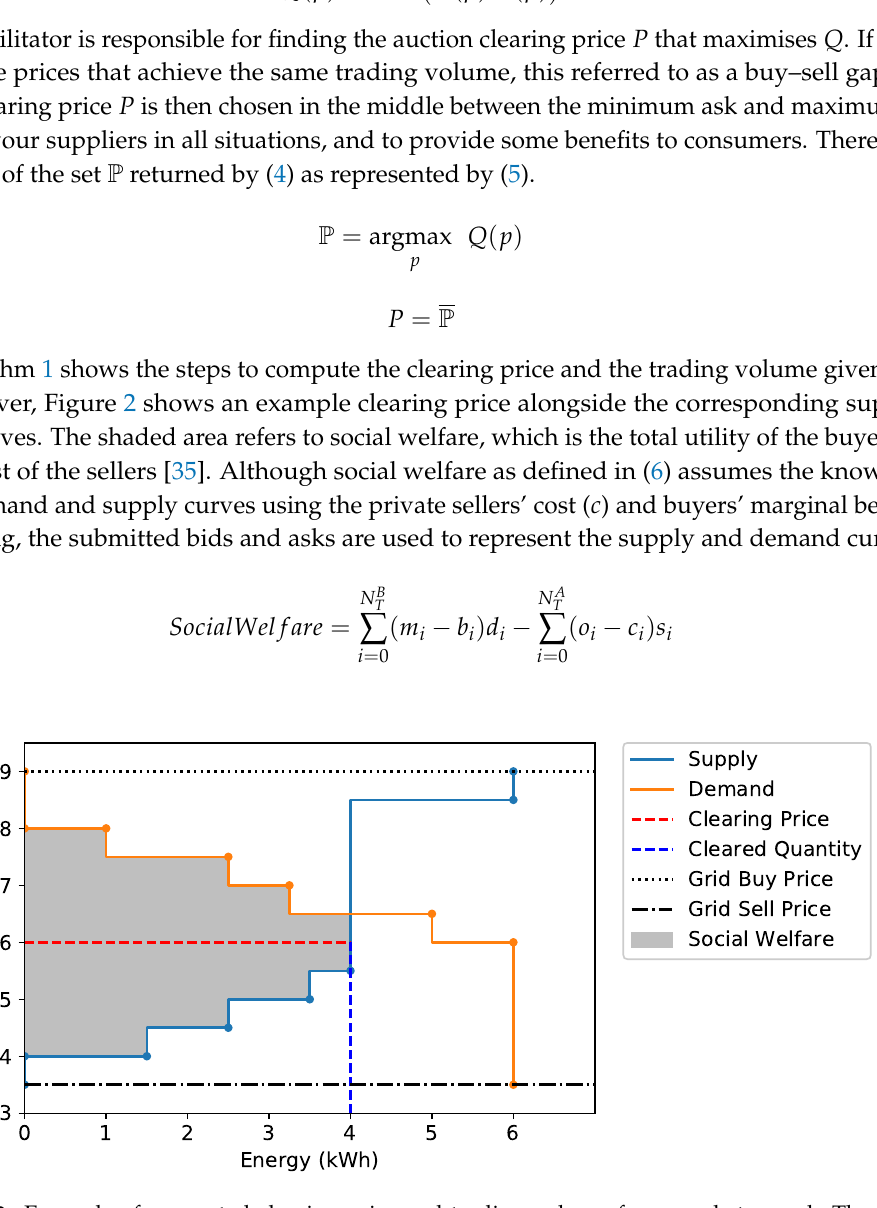
Figure 2. Example of computed clearing price and trading volume for a market round. The bids and asks prices are always within the grid prices. The clearing price is in the middle of the buy–sell gap. Demand/supply at any price is the aggregate bids/asks that could be fulfilled using this price. The shaded area corresponds to social welfare using the bids and asks as the traders private